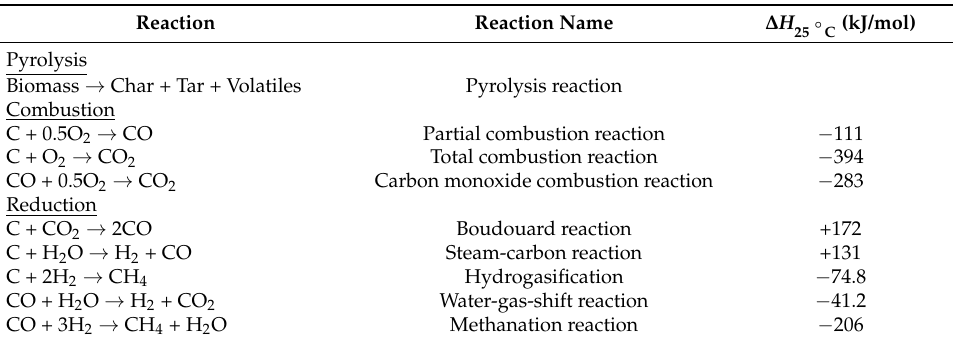
Table 1. Basic reactions in gasification of carbonaceous materials